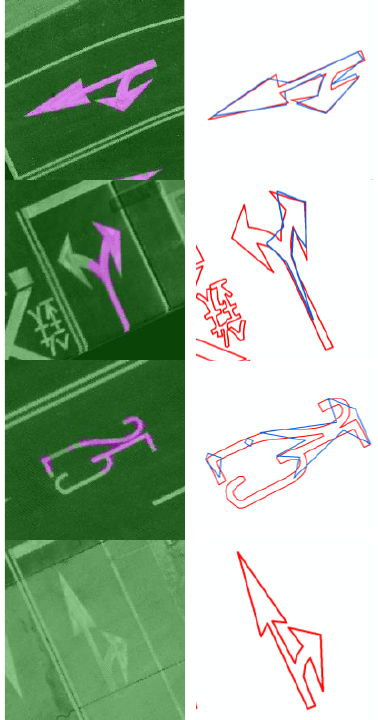
Figure 12. Road arrow polyline classifications: (Top to Bottom) Fully Detected, Partially Detected, Wrongly Detected, and Not Detected. (Left) Segmented Image and (Right) arrow polyline, in which Red is manually digitized and Blue is detected from the neural network